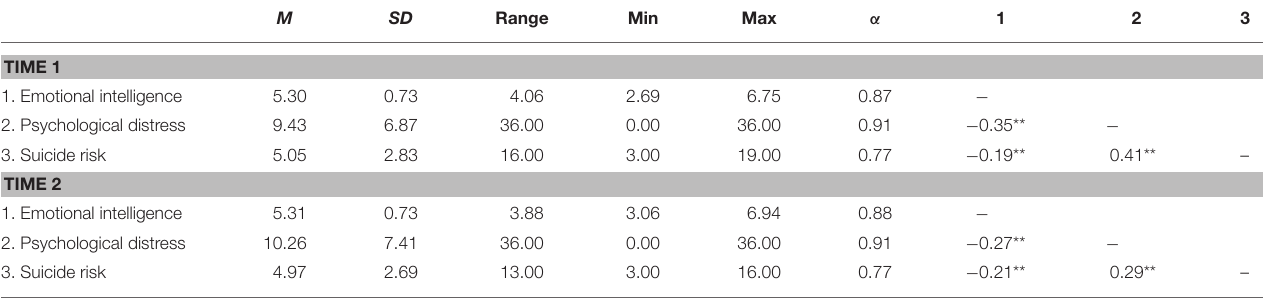
TABLE 3 | Descriptive statistics and bivariate correlations among the study variables at Time 1 and Time 2 in Study 2. M SD Range Min Max α 1 2 3 TIME